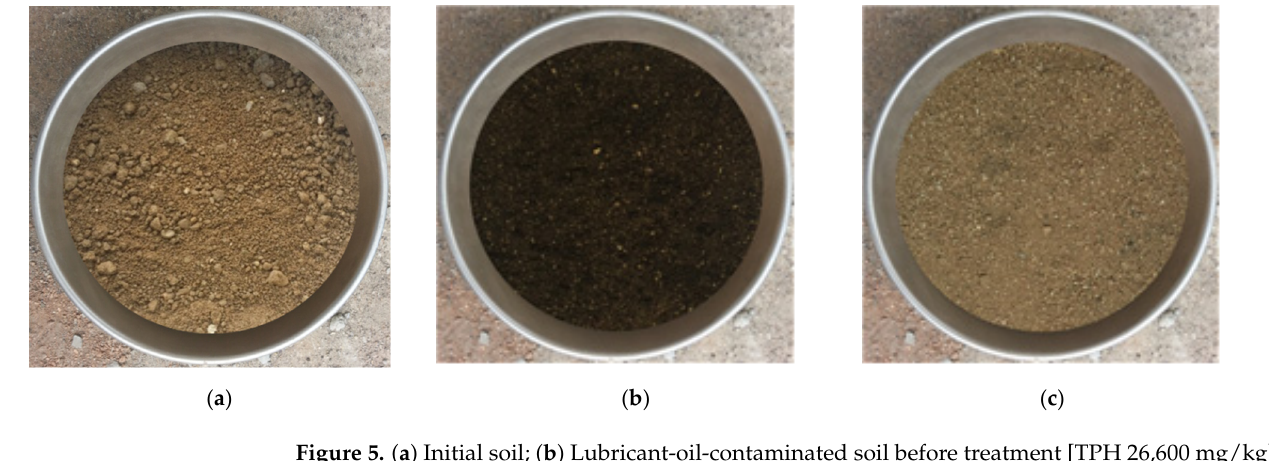
Figure 5. ( a ) Initial soil; ( b ) Lubricant-oil-contaminated soil before treatment [TPH 26,600 mg/kg]; ( c ) Cleaned soil after treatment (600 °C) [TPH 38.2 mg/kg].